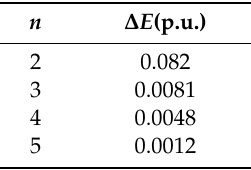
Table 8. Singular entropy increments with di ff erent decomposition